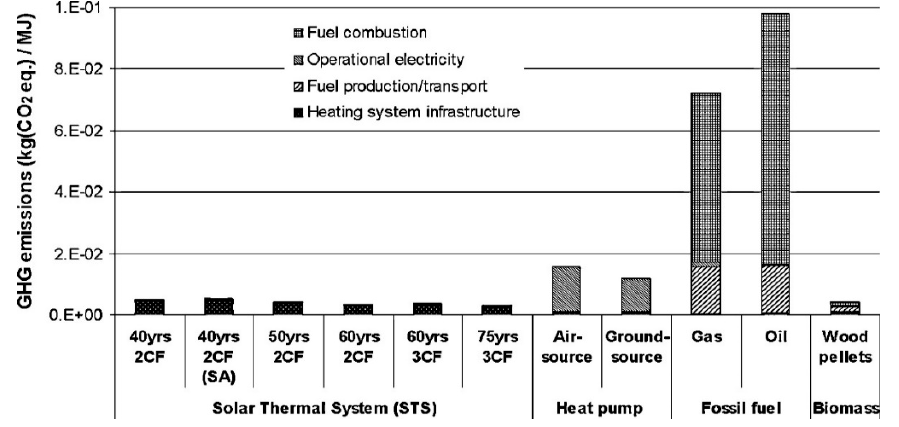
Figure 4. Life cycle GHG emissions of each heating system [16].